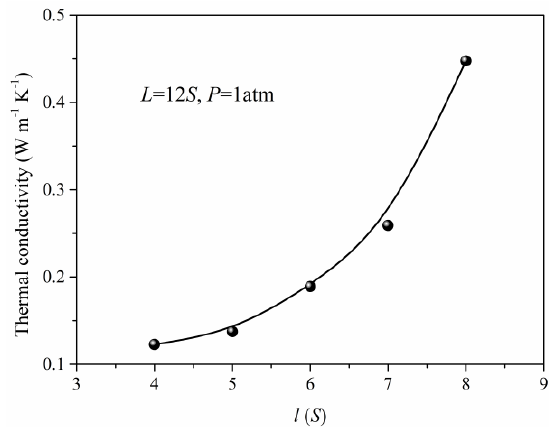
Figure 7. The thermal conductivity for different width ( l ).